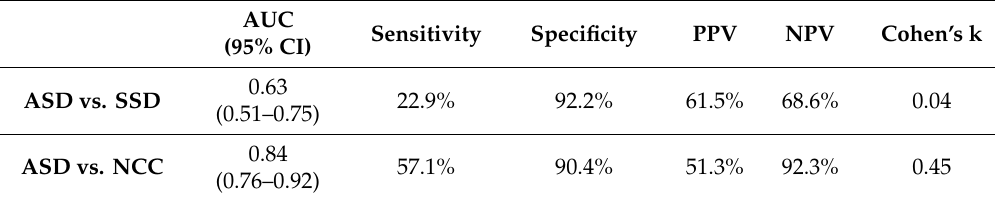
Table 3. Accuracy of AQ in discriminating ASD from SSD and NCC.